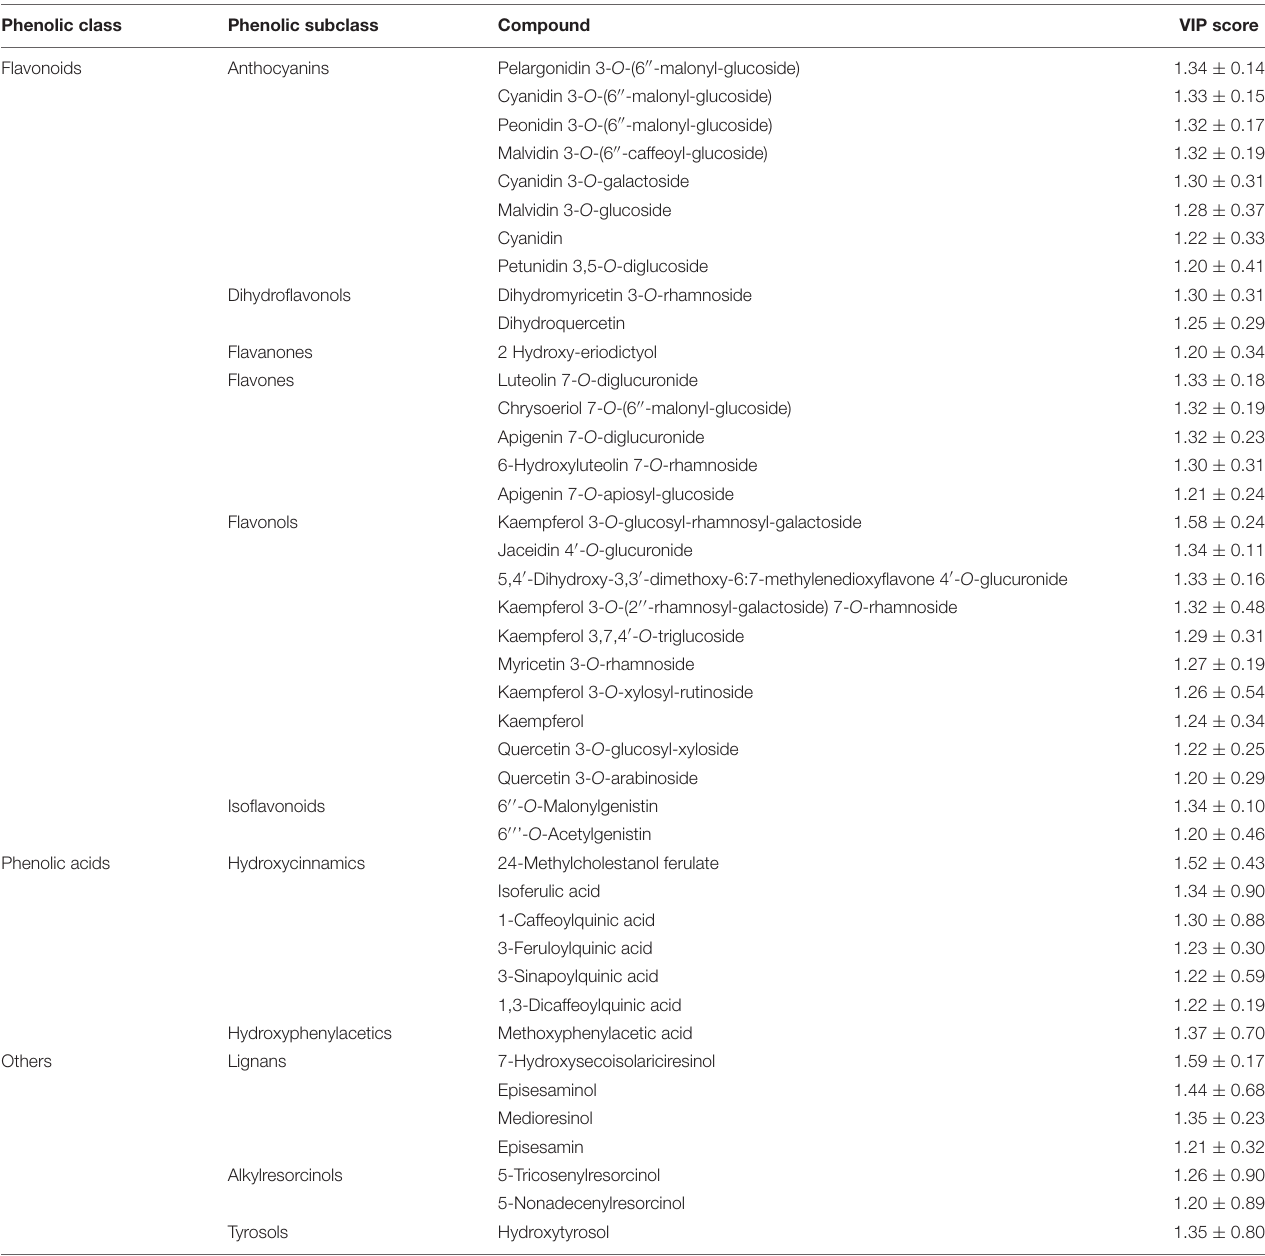
TABLE 4 | Compounds better discriminating between different maize genotypes, as selected by VIP analysis following OPLS-DA. Phenolic